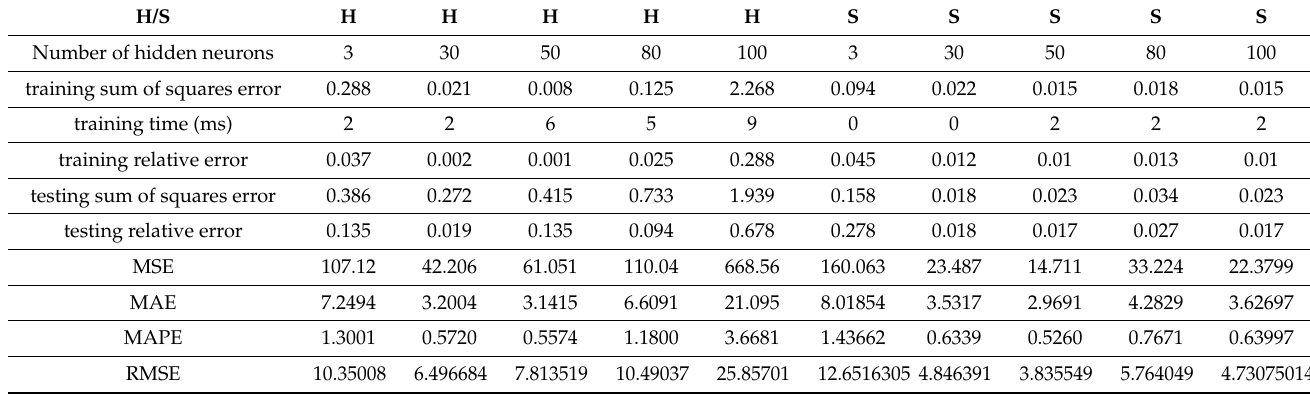
Table 6. PCA–ELM models using a hyperbolic tangent function and sigmoid function with differ- ent ranges of hidden neurons.